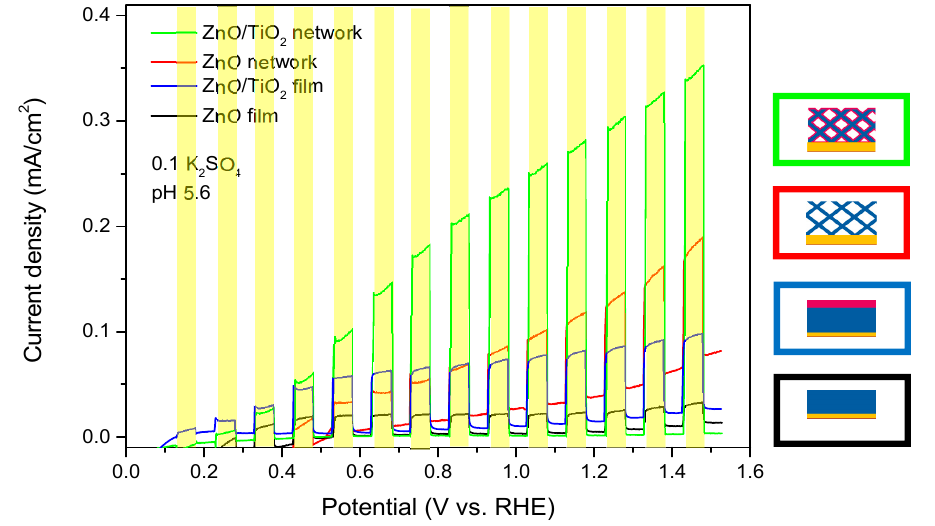
Figure 7. Linear sweep voltammograms of the bare ZnO, and TiO 2 -coated ZnO nanowire networks and films described in Figure 6. The nanowire density is 4 × 2 × 10 9 cm − 2 and the nanowire diameter is ~150 nm, in all cases. The 20 nm thick TiO 2 coating layers were prepared by ALD at 250 °C. The LSVs were measured under chopped light illumination (light on areas marked in yellow) with a scan rate of 10 mV/s.